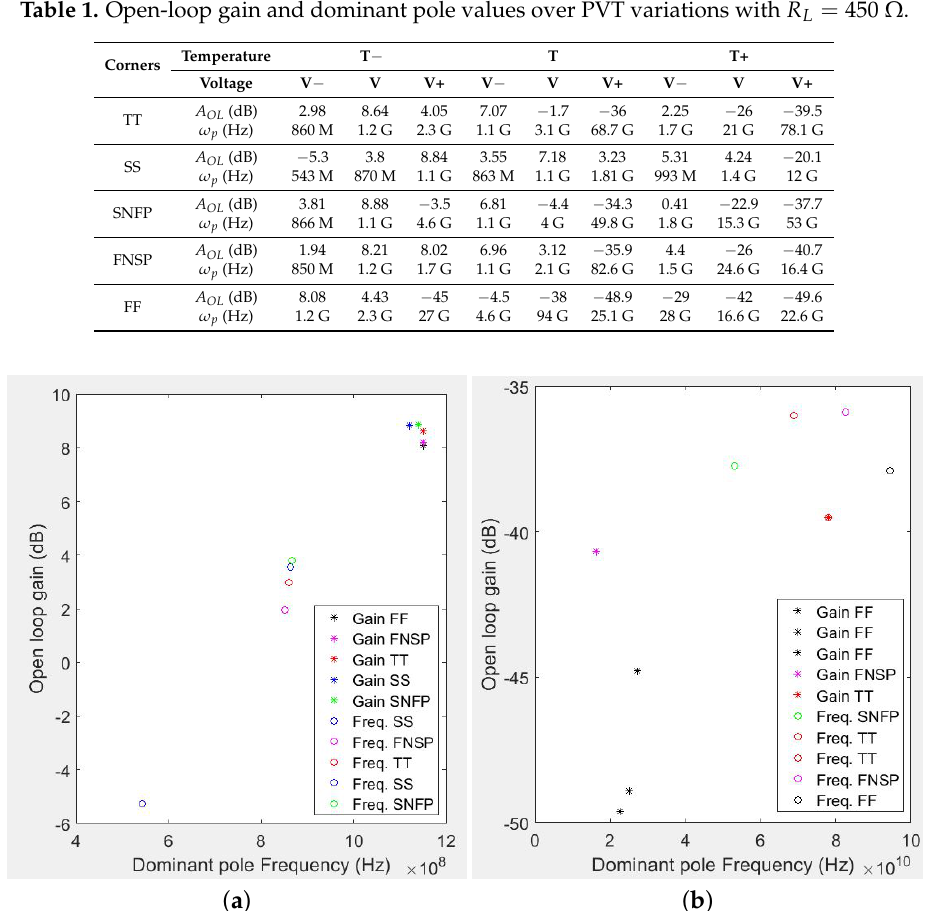
Figure 4. ( a ) Higher and ( b ) lower gains and dominant pole frequencies with R L = 450 Ω